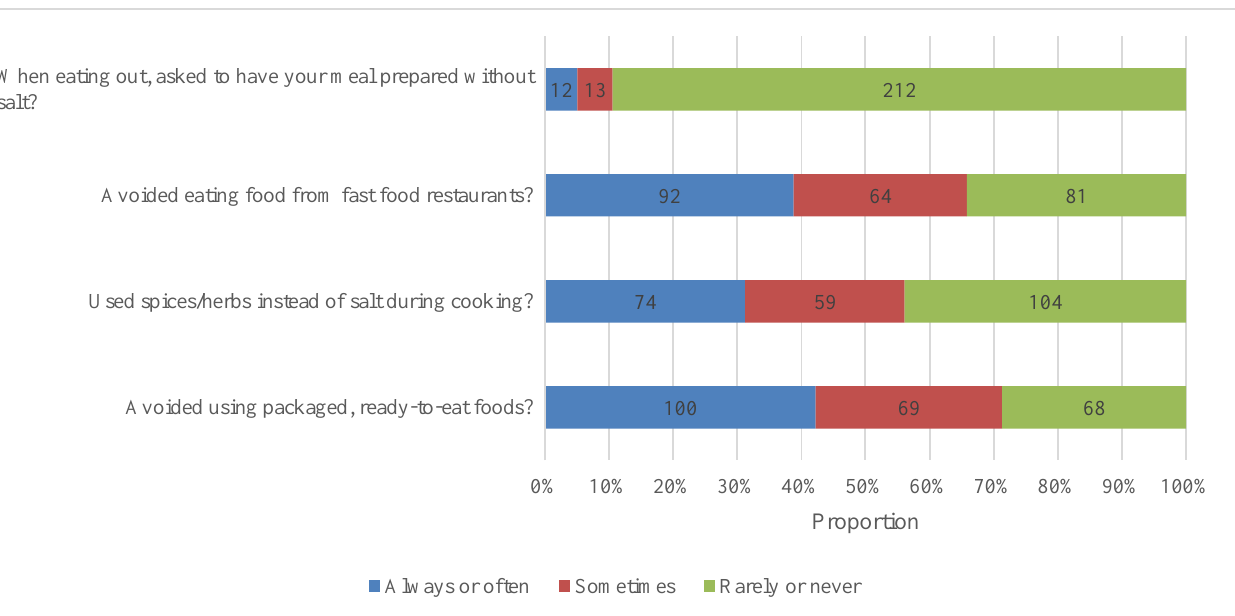
Figure 2. Behavioral practices to reduce salt intake performed in the past